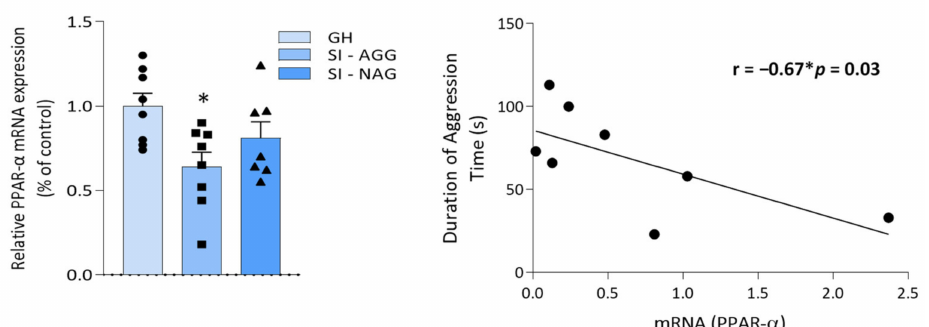
Figure 1. PPAR- α mRNA expression in the hippocampus of socially isolated (SI) mice and its correlation with aggressive behavior. ( A ) A group of mice that failed to develop aggressive behavior (here termed SI non-aggressive, SI-NAG) during protracted social isolation was separated from the SI mice that showed high aggressive behavior scores (SI-AGG). Decreased PPAR- α mRNA expression in the hippocampus of SI-AGG mice was observed when compared with GH or SI-NAG mice (one-way ANOVA: * p = 0.03; F = 3.8). Values are means ± S.E.M. of eight control (GH), eight SI-AGG, and seven SI-NAG mice. ( B ) A significant negative correlation exists between PPAR- α mRNA expression and aggressive behavior (Pearson’s r = − 0.67; * p = 0.03, n =